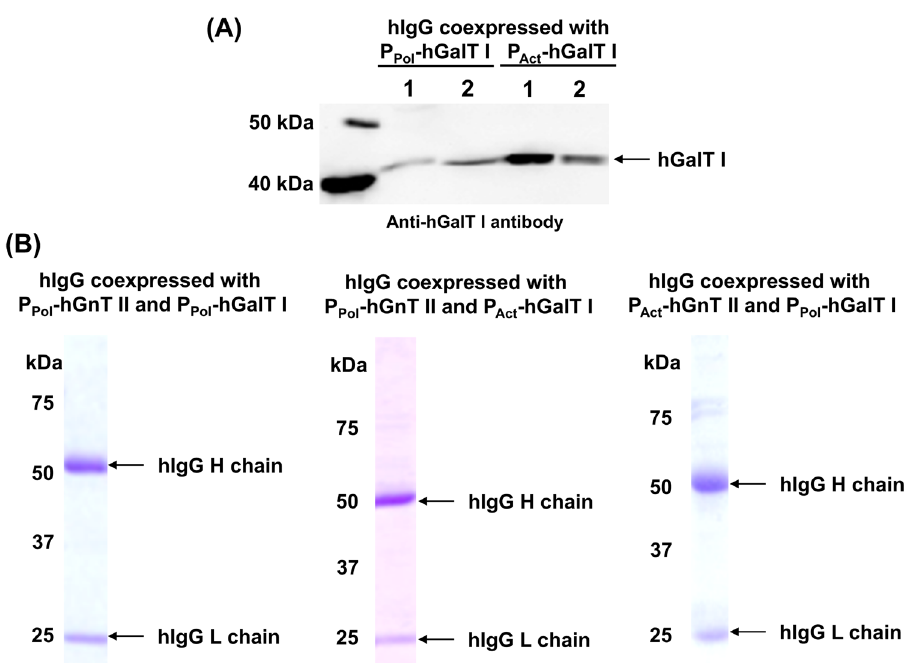
Figure 5. Expression of recombinant proteins in silkworm pupae with coexpression of hGnT II and hGalT I. ( A ) Expression of hGalT I in silkworm pupae by using BmNPV CP − Chi − /P Act -hGalT I or BmNPV CP − Chi − / P Pol -hGalT I. Pupae were homogenized with TBST and centrifuged to separate the supernatant from the insoluble material. Western blotting was performed on both fractions. Lane 1: Supernatant, lane 2: Pellet. ( B ) SDS-PAGE of purified hIgG coexpressed with P Pol -hGnT II and P Pol -hGal T I (left panel), P Pol -hGnT II and P Act - hGal T I (middle panel) and P Act -hGnT II and P Pol -hGal T I (right panel). Gels were stained with